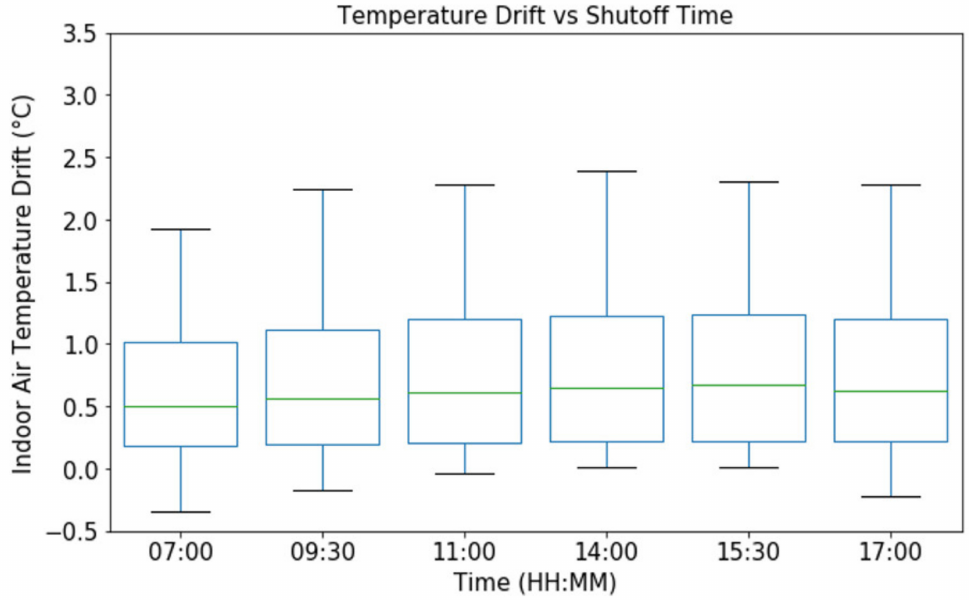
Figure 10. Box and whisker plot of internal air temperature drift vs. shutoff time for all scenarios, with median represented by green horizontal